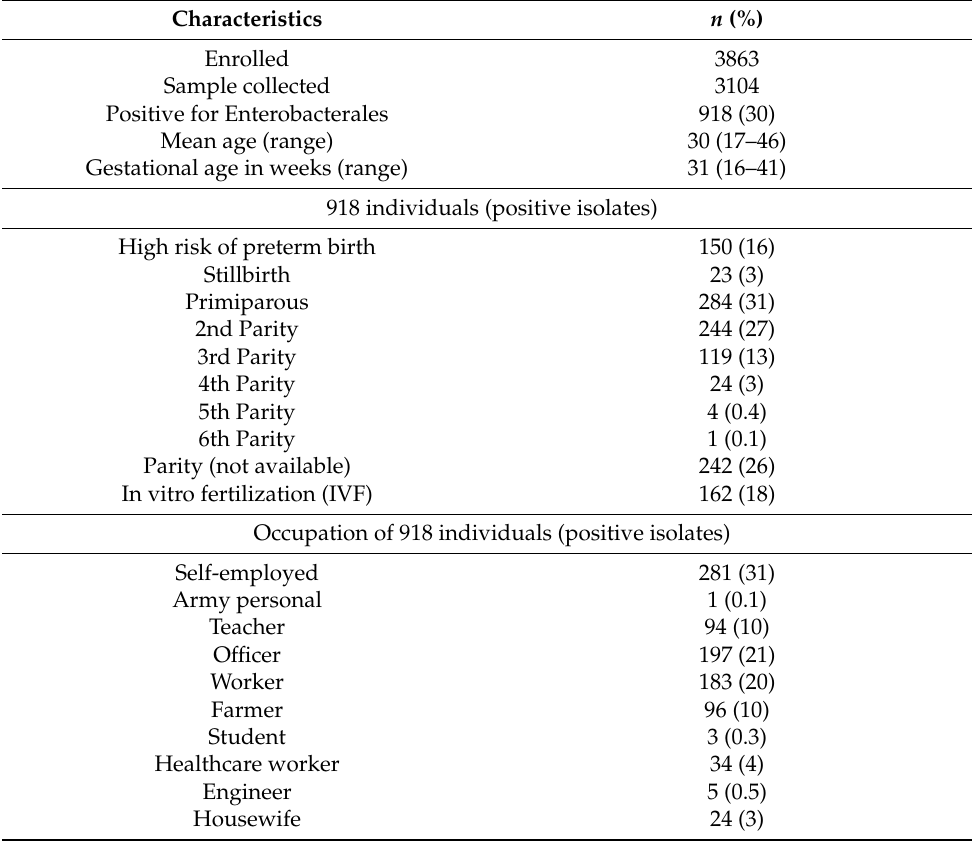
Table 1. Baseline characteristics of enrolled participants.